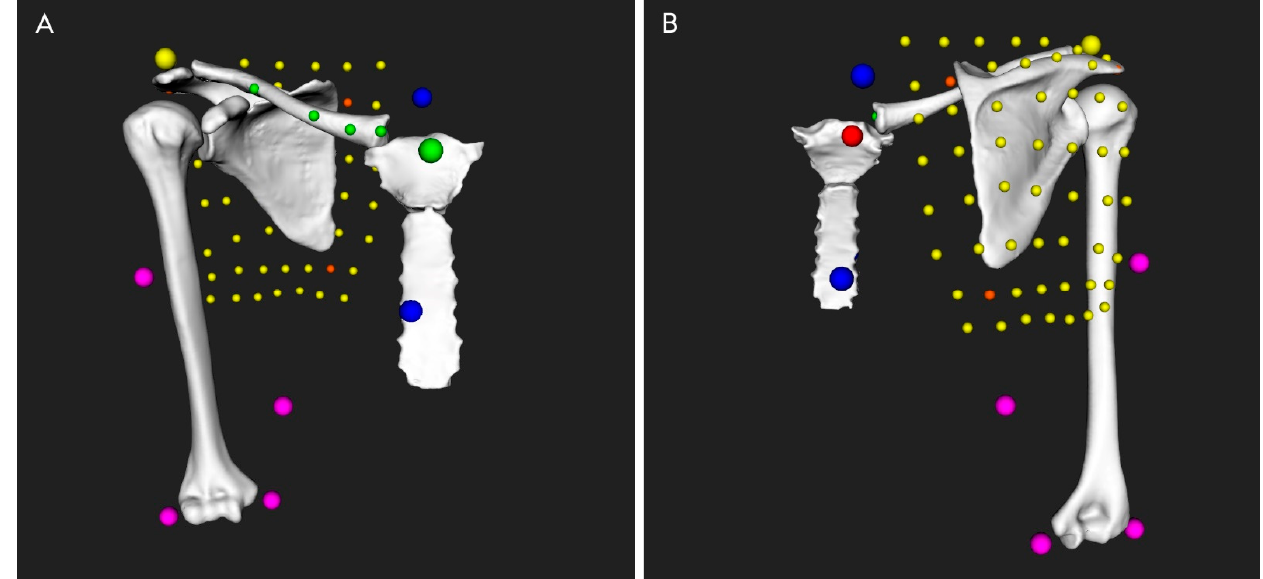
Figure 4. Front (A) and back (B) views of the markers setup on the shoulder (right shoulder). The colored dots represent the retro-reflective skin markers.